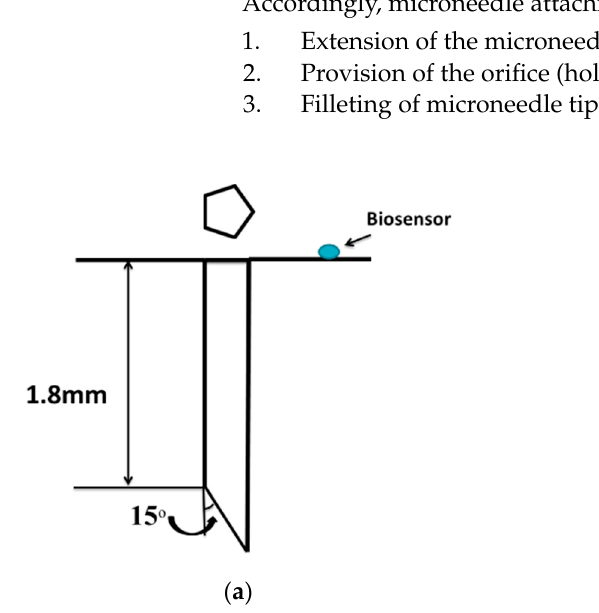
Figure 3. Schematic diagram of ( a ) flushed pentagonal microneedle and ( b ) 0.5-mm microneedle extension with a hole.